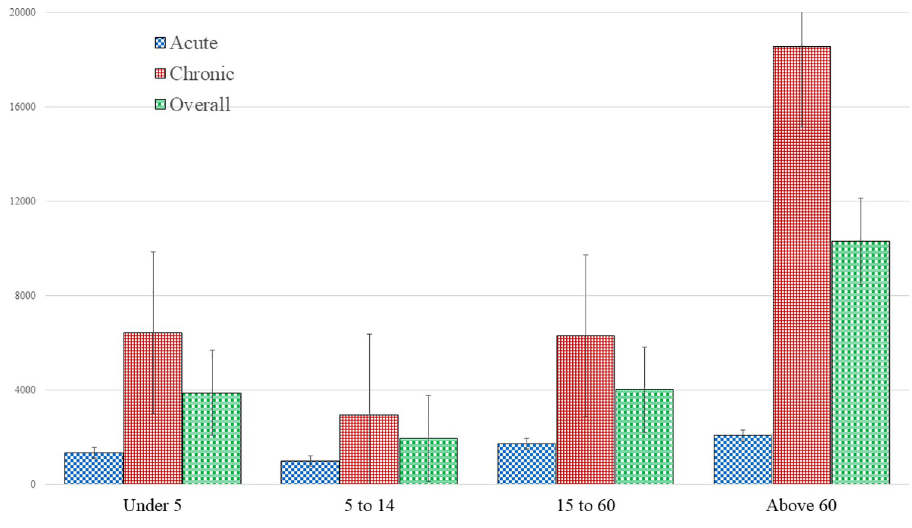
Fig 1. OOP cost across age of the study sample.